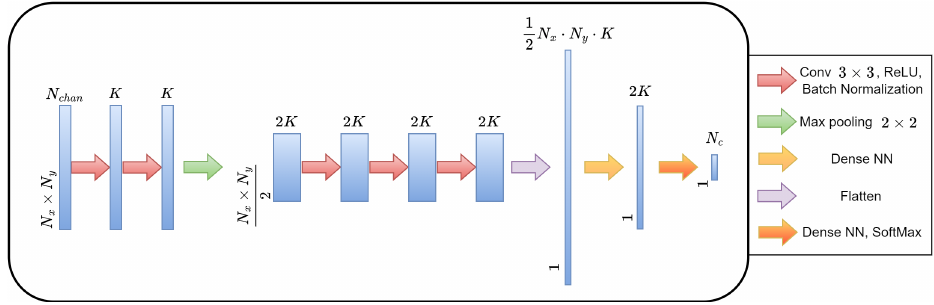
Figure 3. Convolutional neural network diagram for classification problems.